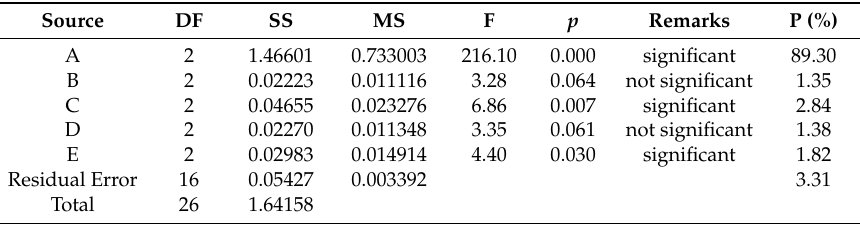
Figure 2. Main effect plots for S/N ratios [Response: TE]. Table 6. ANOVA for the S/N ratio (TE).